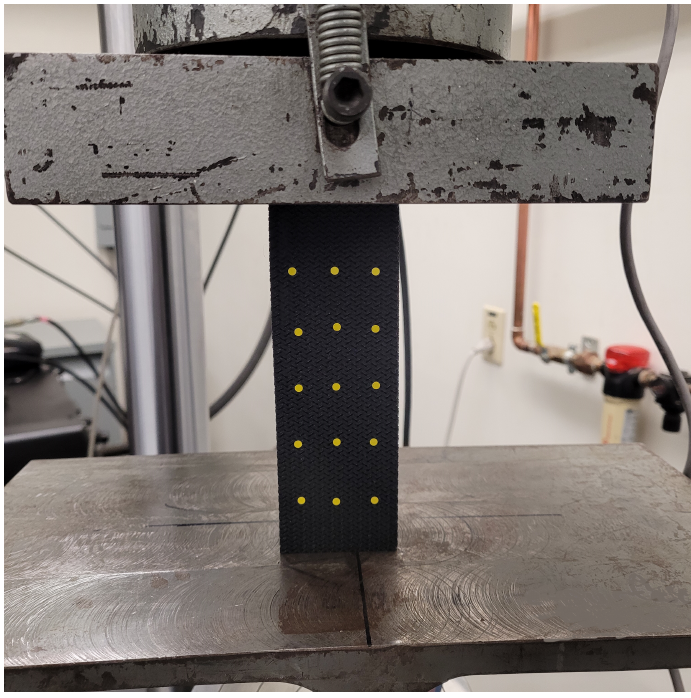
Figure 6. Gyroid prismatic specimen in the compression fixture.